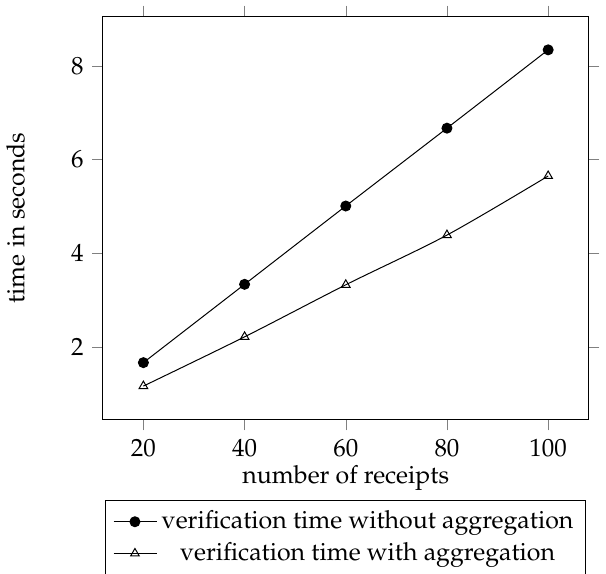
Figure 4. Receipt verification latency according to